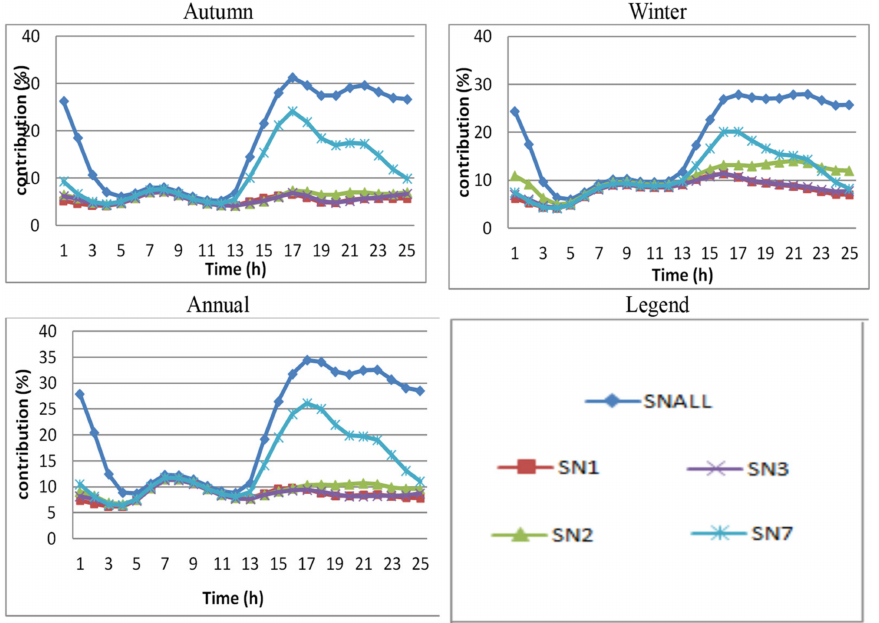
Figure 3. Annual and seasonal averaged relative contribution (%) of all emissions and emissions from different SNAP categories to the formation of NO 2 concentration in Sofia for the period 2008–2014.